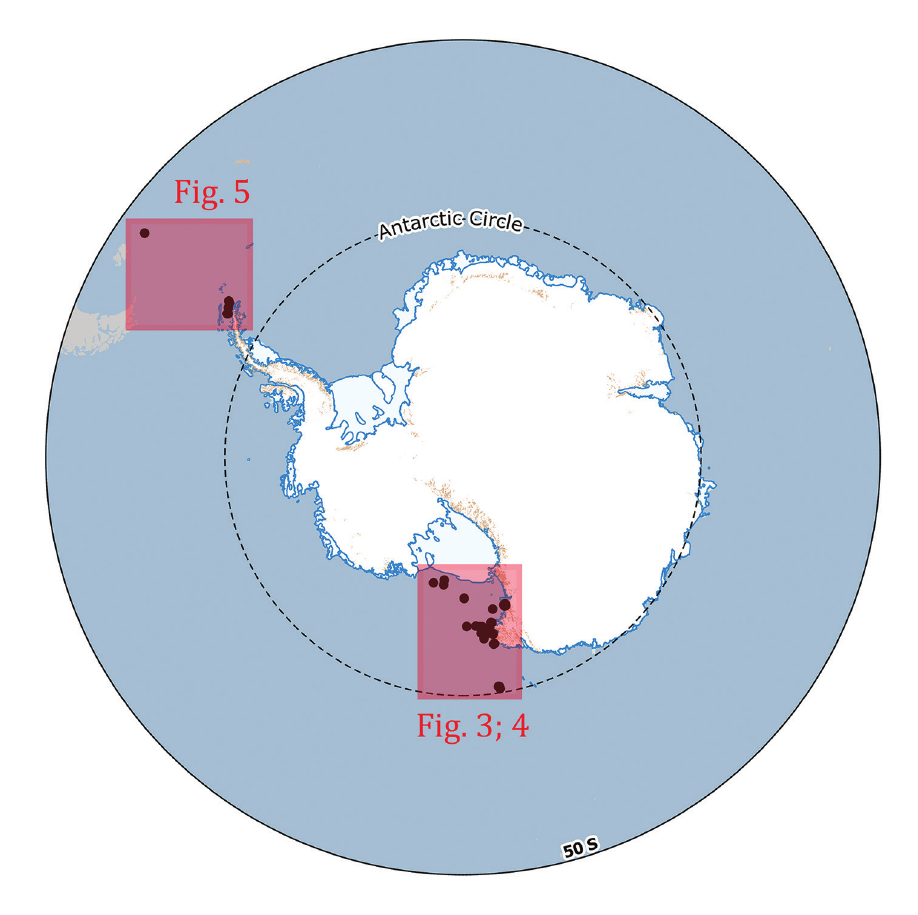
Figure 2. Overview map depicting the wideness of the area containing the sampling stations of the data- set. Areas in red are shown in detail in figures 3, 4 and